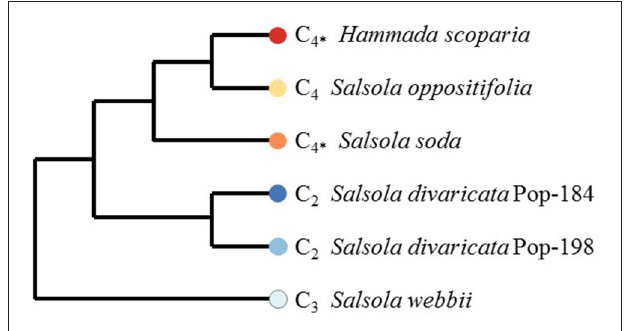
FIGURE 1 | Highly reduced phylogenetic tree including only species of the current study [adapted and modified from Open Access article by Schüssler et al. (2016), which permits unrestricted reuse; C 4* , species with C 4 photosynthesis in leaves/assimilation shoots but C 3 in cotyledons].